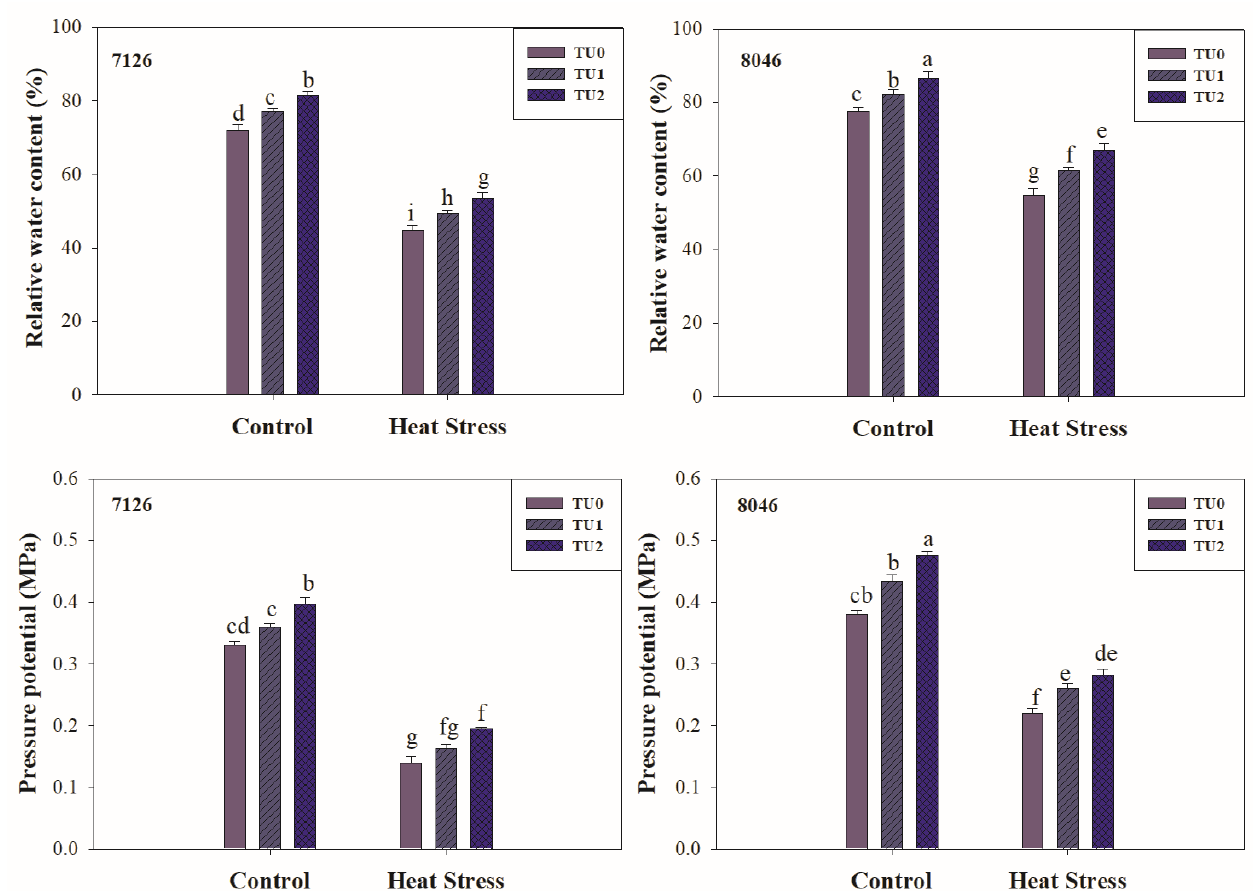
Figure 2. Impact of thiourea priming (TU 0 = control–no application, TU 1 = Water priming, TU 2 = Thiourea priming (500 ppm) and heat stress (32 °C) on pressure potential (MPa) and relative water content (MPa) on camelina genotypes 7126 and 8046. Error bars above means indicate the ± S.E. Means sharing the same letter in both varieties do not differ significantly at p ≤ 0.05. Table 3. Impact of thiourea priming and heat stress on growth and yield parameters of two camelina varieties. Varieties